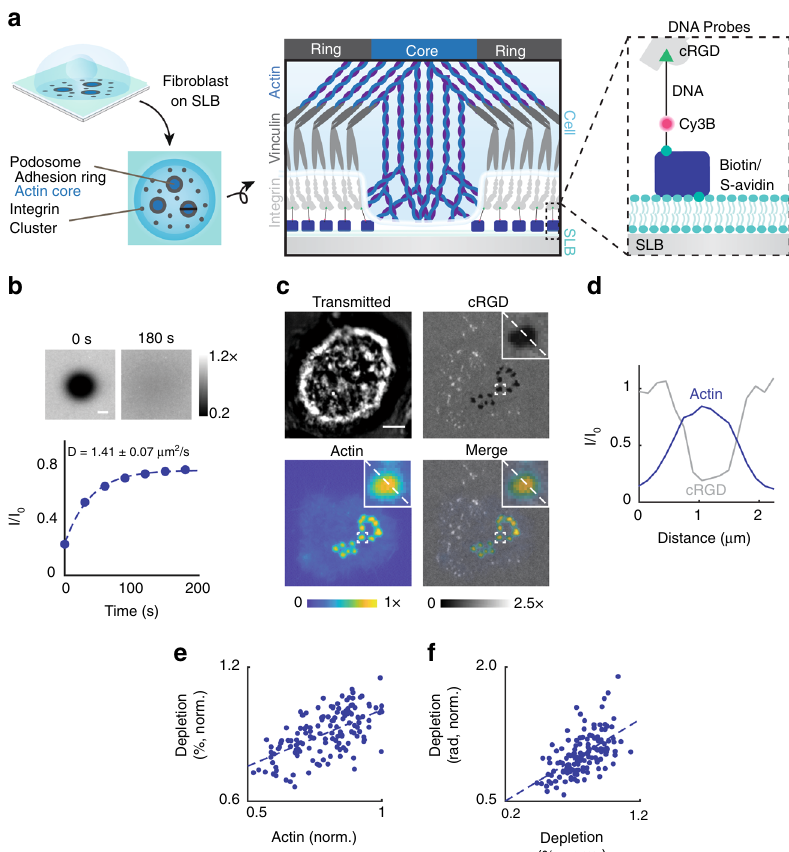
Fig. 1 NIH 3T3 fi broblasts form protrusive podosomes on SLBs. a (Left) Schematic of the SLB podosome model. (Middle) Schematic of a single podosome at the cell – SLB interface across the black line. Podosomes exclude RGD-probes at their protrusive core. (Right) Zoomed-in schematic of a single DNA probe. b Representative images and mean intensity plot of RGD – DNA probes in a fl uorescence recovery after photobleaching experiment. Data were normalized to the SLB intensity at t = 0 s. DNA probes had a diffusion coef fi cient of 1.41 ± 0.07 μ m 2 s − 1 (mean + s.e.m., n = 9 FRAPs, 3 experiments). Scale bar, 10 µ m. c Representative podosome-forming cell on an SLB decorated with single-stranded DNA probes. Cells were transfected LifeAct to visualize actin cores. Scale bar, 5 μ m. d Linescan analysis across the zoomed-in podosome in c . cRGD and actin intensity are normalized to the SLB background and the brightest pixel, respectively. e , f Scatter plots of actin intensity versus depletion (%) and depletion (%) versus depletion radius. All data were normalized by the brightest podosome per cell to account for varying LifeAct expression. ( r = 0.657, 0.604, N = 161 podosomes, 23 cells, three experiments). Source data are provided as a Source Data fi